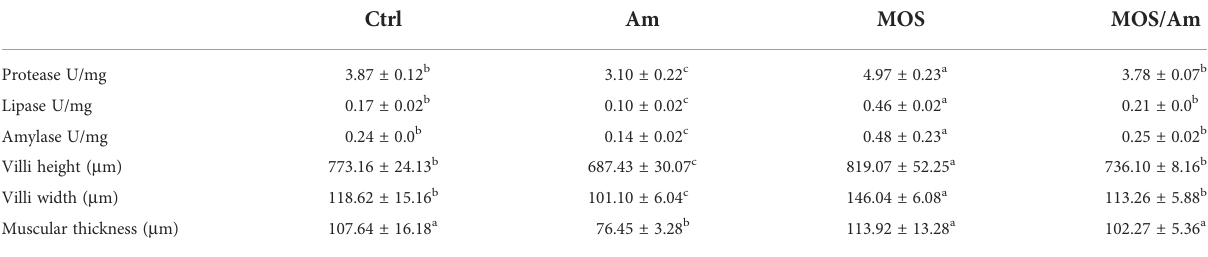
TABLE 6 Effects of dietary MOS on the intestinal digestive enzyme and intestinal morphology of the common carp under ammonia stress for 30 days.